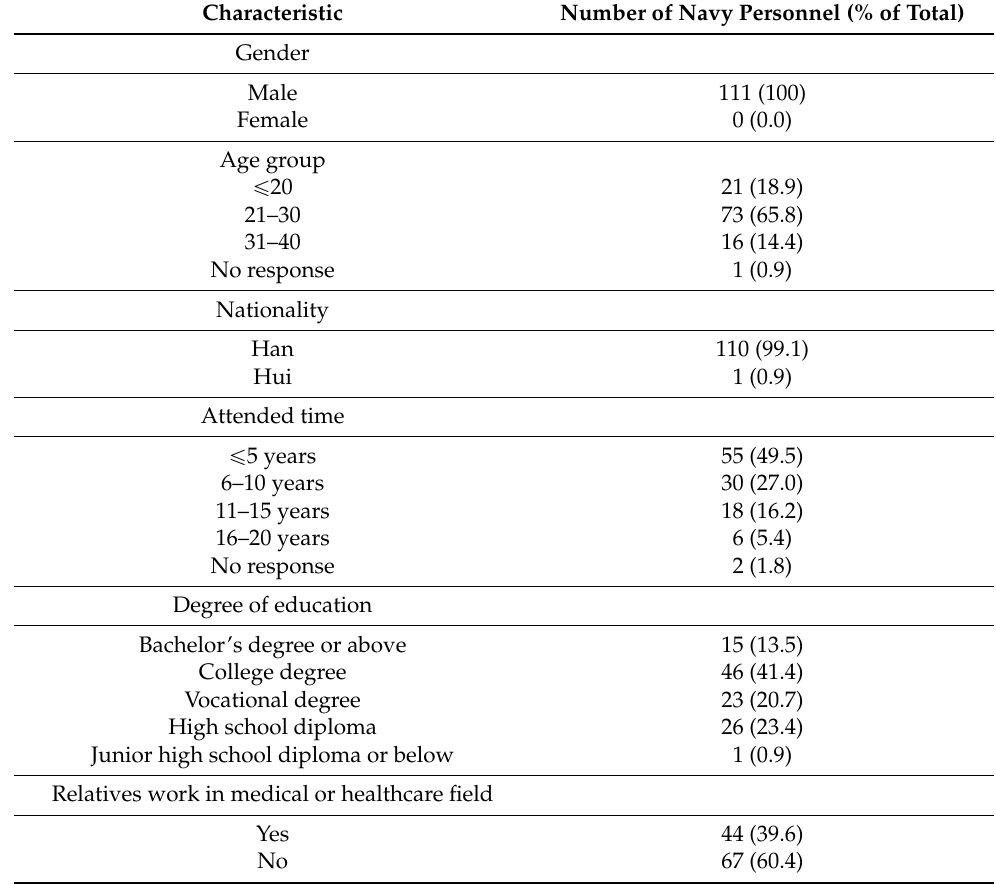
Table 1. Demographic characteristics of participants ( n = 111, all